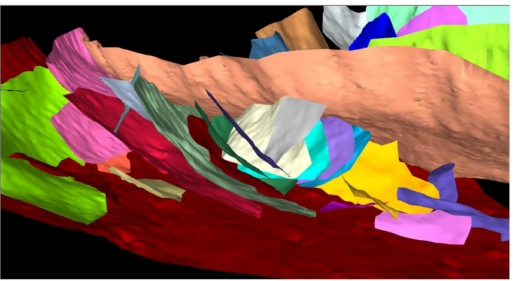
Figure 21. Schematic diagram of the results of complex fault model